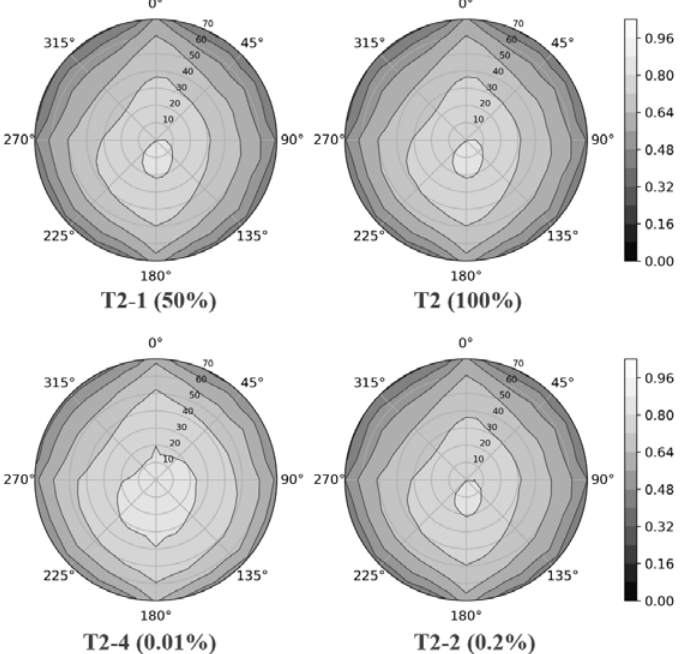
Figure 9. Gap fraction polar contour diagrams for the second stage (25 September 2019).